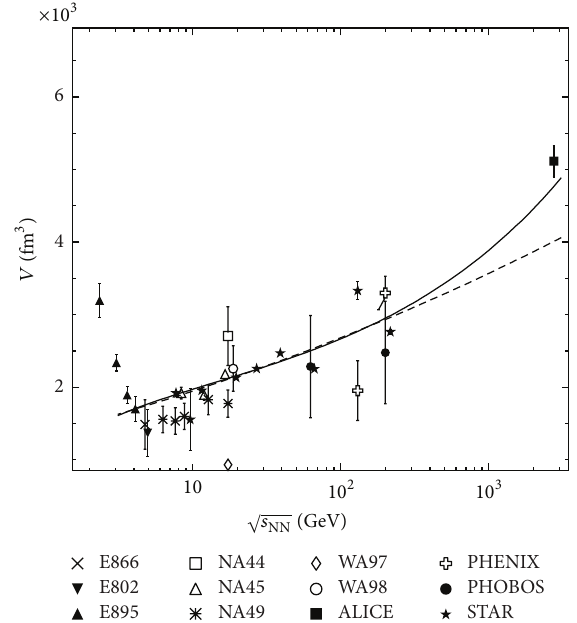
Figure 3: Energy dependence of volume of emission region at freeze-out for secondary charged pions in central heavy ion col- lisions Au + Au, Au + Pb, Pb + Pb in midrapidity region and at ⟩ ≃ 0.2 GeV/ 𝑐 . Equation (3) is used for calculation of volume ⟨𝑘 ⊥ values. Experimental results are shown for the same particle types and Coulomb corrections as well as in Figure 1. Error bars are only statistical (for NA44, total uncertainties). Smooth curves are derived from (3) and the fit results for 𝑅 𝑠 , 𝑅 𝑙 taking into account the point of the WA97 experiment [11]. The solid line corresponds to the fits of HBT radii by function (7) and dashed line to the fits by specific case ∝ ln 𝜀 , 𝑖 = 𝑠,𝑙 𝑅 𝑖